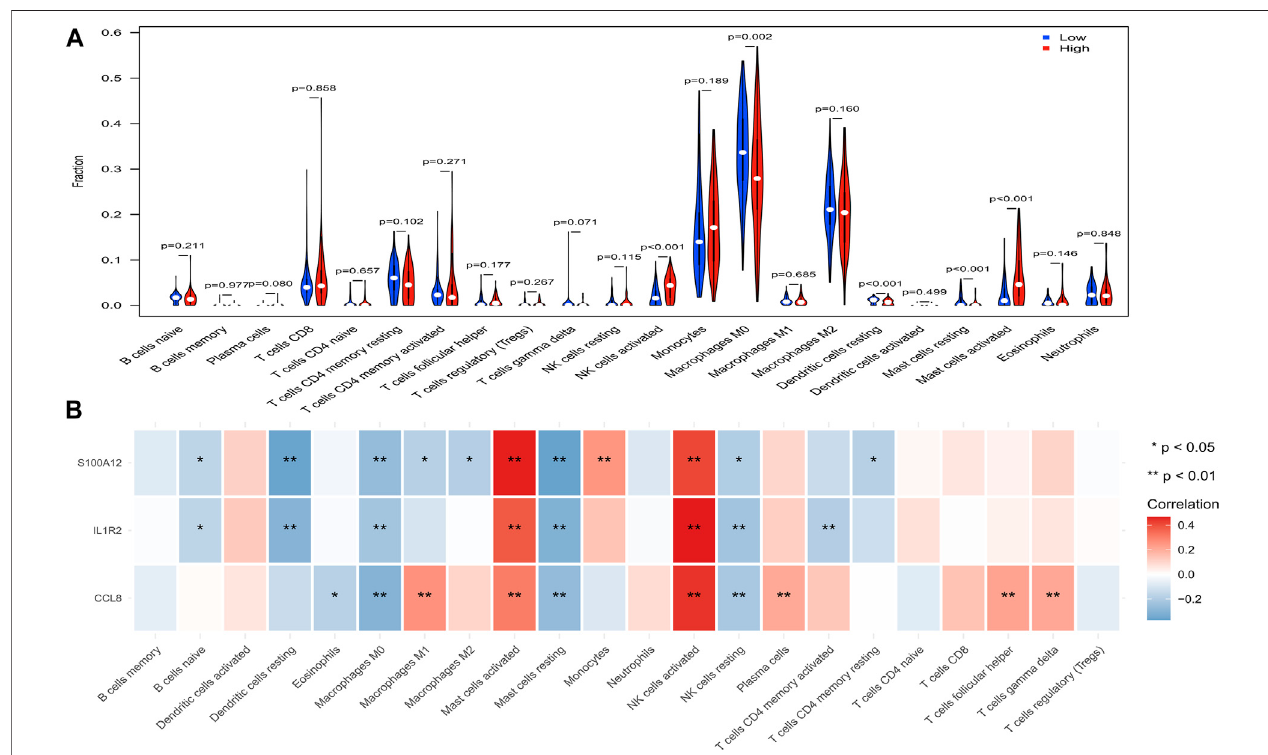
FIGURE 8 | Analysis of immune in fi ltrating cells in high- and low-risk groups in the training set. (A) Comparison of in fi ltrated immune cells in high- and low- risk groups. (B) Correlation between IL1R2, S100A12, and CCL8 and in fi ltrated immune cells.